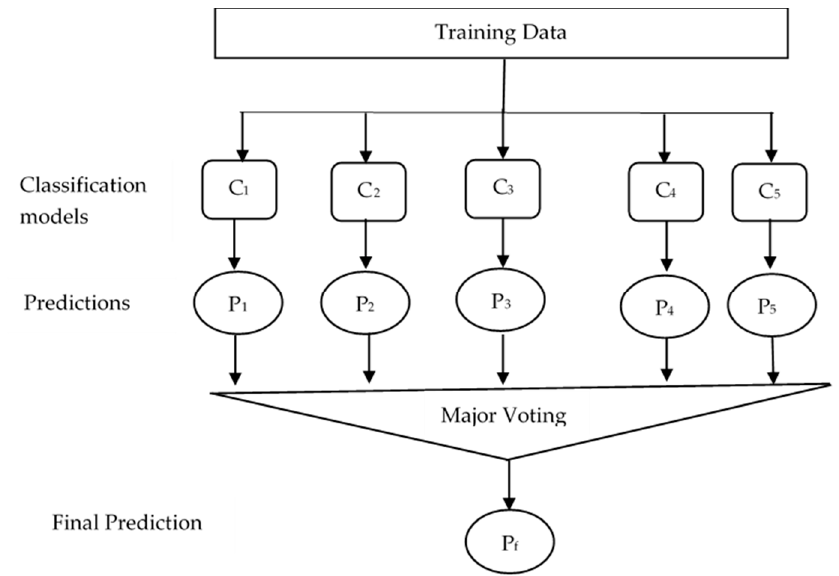
Figure 13. Block diagram of ensemble classifiers. (where C1 = LD, C2 = SVM, C3 = KNN, C4 = Boosted trees, and C5 = Bagged trees). LN, linear discriminant; SVM, support vector machine; KNN, k-nearest neighbor.